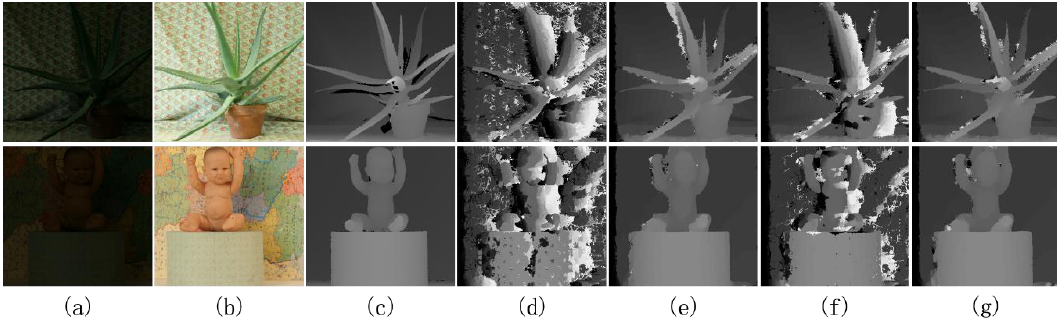
Figure 9. Disparity maps with di ff erent exposures of Aloe and Baby1. ( a ) Left image with Exposure 0; ( b ) right image with Exposure 2; ( c ) ground truth; ( d ) cost combined SAD with gradient; ( e ) cost combined AD with census transform; ( f ) combination of AD, gradient and census; ( g ) the proposed cost function. Table 2. Error matching rate of various cost computation under di ff erent illumination.